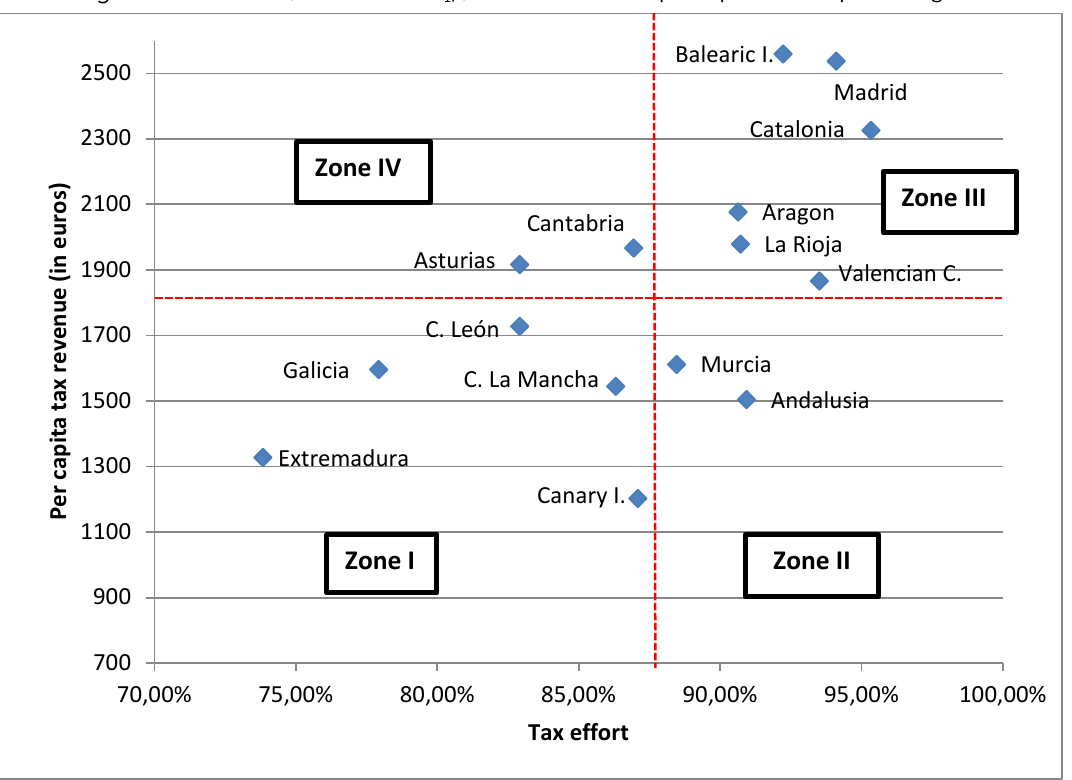
Figure 1 : Tax effort (SFA-INCOME IV ) and tax collection per capita in the Spanish